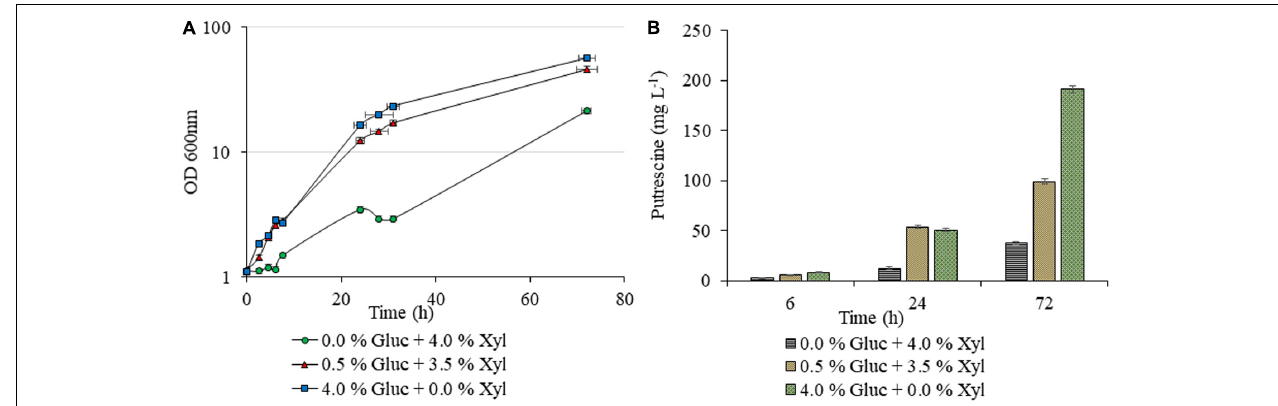
FIGURE 2 | Putrescine production of C. glutamicum PUT Xyl. Growth curves of C. glutamicum PUT Xyl cultivated in shake flasks of 20 mL CGXII minimal medium supplemented with different compositions of glucose (Gluc) and xylose (Xyl) (A) , and putrescine concentrations measured after 0, 6, 24, and 72 h of cultivation (B) . Measurements are given as means from triplicates of independent cultivations with standard